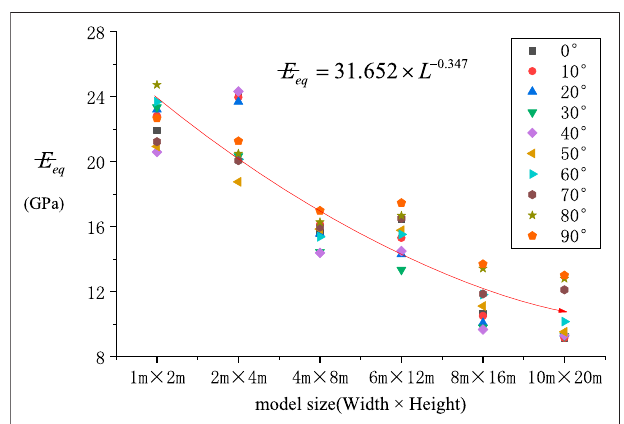
FIGURE11| Relationshipbetweentheequivalentelasticitymodulusand model